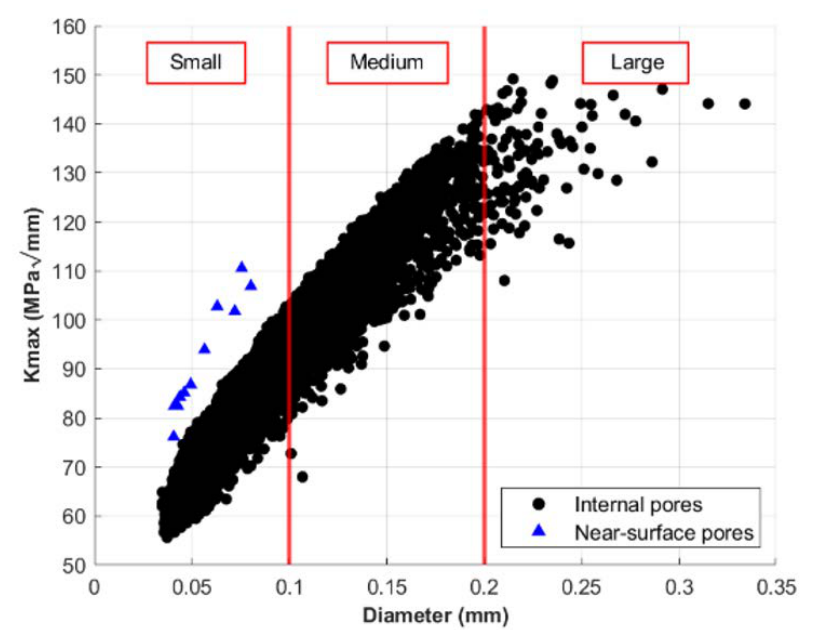
Figure 13. Calculated stress concentration factors K max for each detected pore of the X-ray scan in relation to the pore diameter and